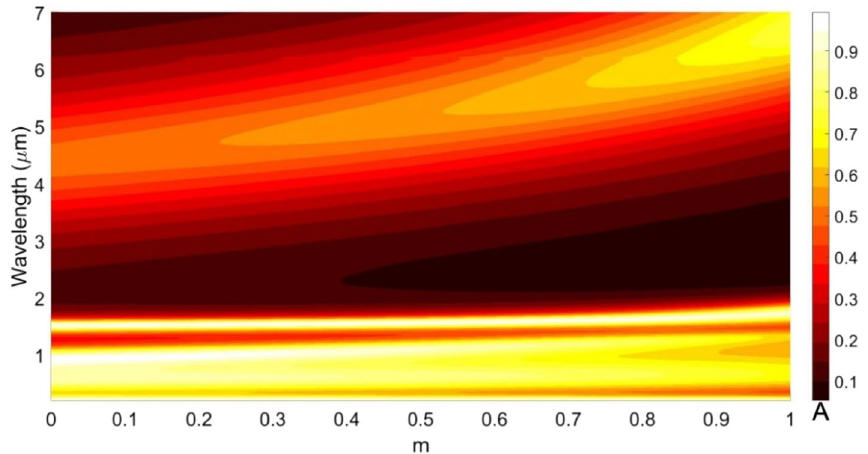
Figure 13. Absorption spectra for different crystalline-to-amorphous ratios of the upper GST layer, while the other parametric and operational conditions are as used in Fig. 9.